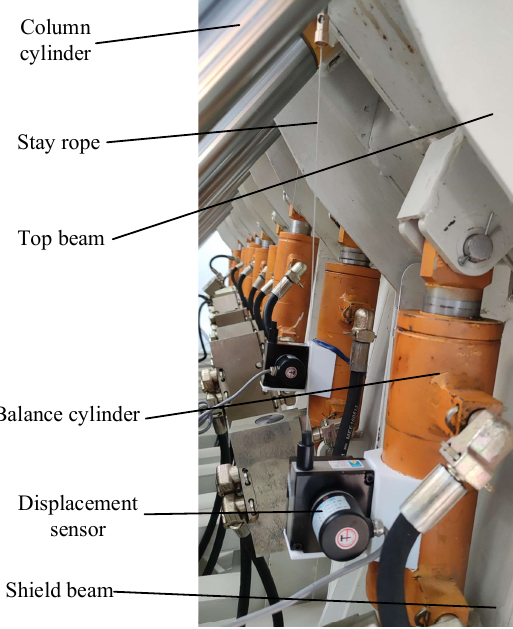
Figure 13. Sample collection experiment of the balanced cylinder of hydraulic support. Set the opening time of the balance cylinder control valve; the displacement of the balance cylinder should be measured. As the stroke of the balance cylinder is shorter and the cylinder diameter is smaller, its displacement is larger in the same action time, and this section only studies the displacement of the balance cylinder at ∆ t = 0.1 s. The displacement data of the hydraulic support balancing cylinder in protruding motion and retraction motion are shown in Figures 14 and 15, respectively.